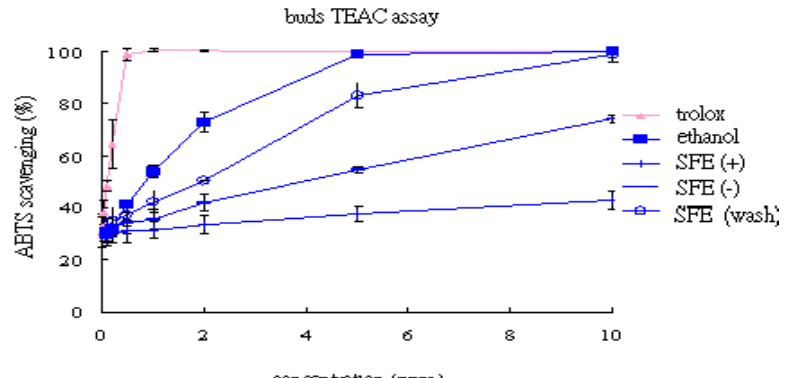
Figure 2. ABTS radical scavenging activity of the various extracts of C.